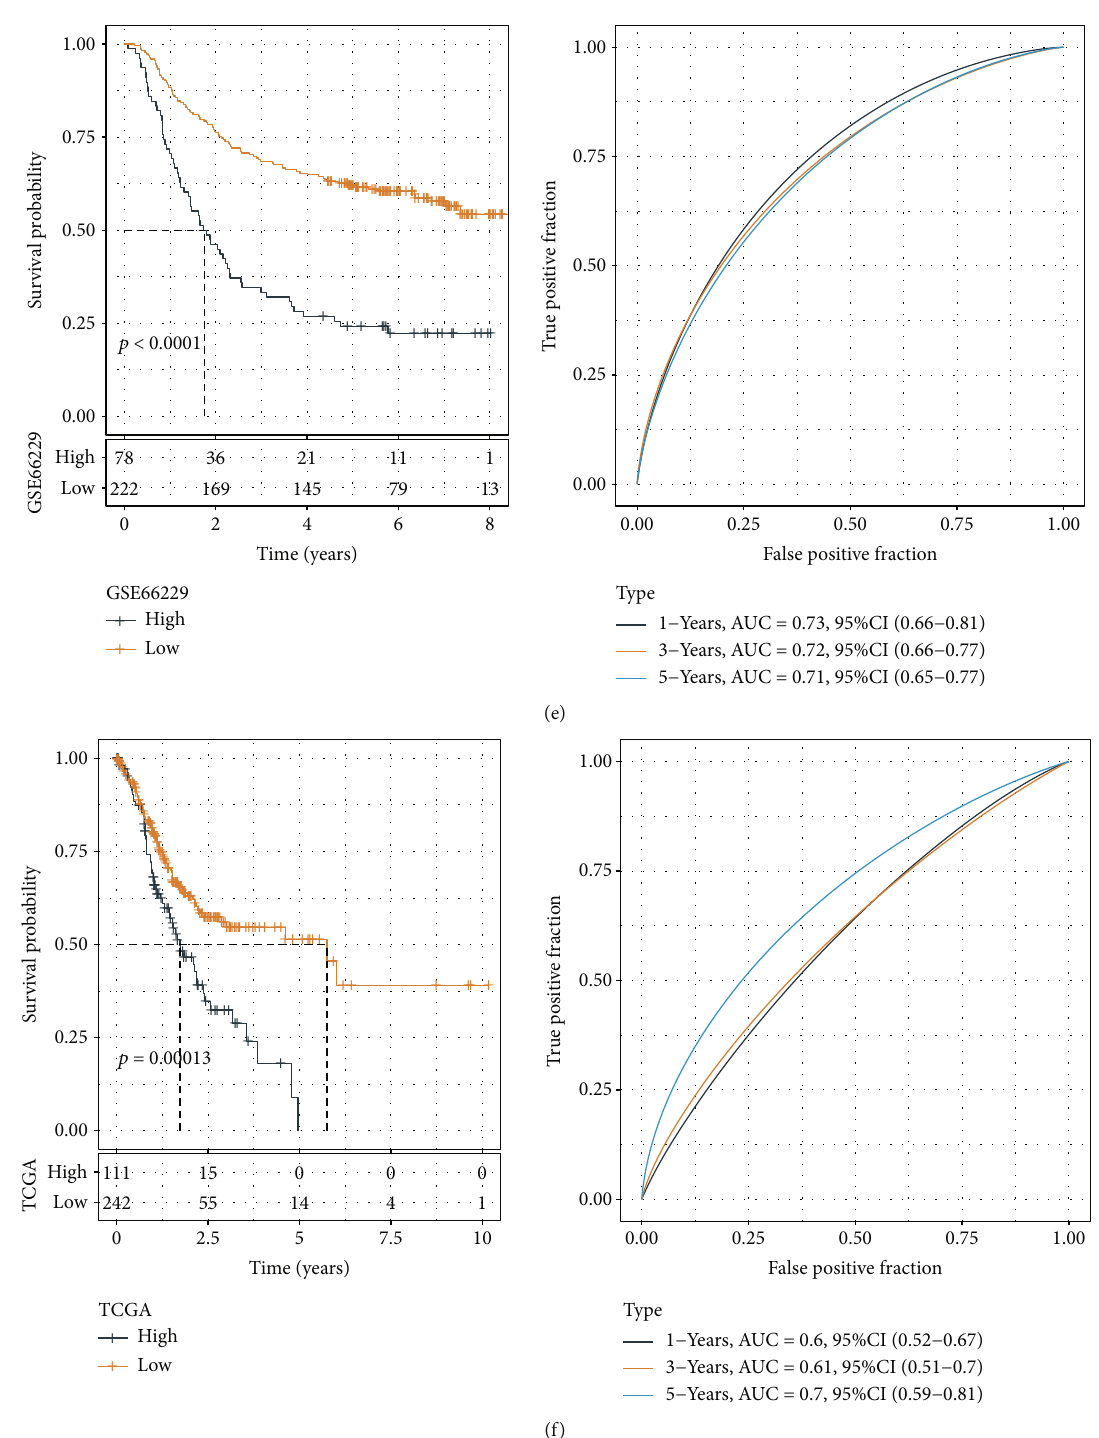
Figure 9: Construction of IRS for STAD. (a) Distribution of LASSO coe ffi cients for 40 prognostic RNAs in the GEO training cohort. Coe ffi cient pro fi les were plotted based on log ð λ Þ sequences. (b) Multifactorial results of genes for the fi nal IRS model. (c) KM and ROC analyses for the IRS model using the GEO training dataset. (d) KM and ROC analyses for the IRS model using the GEO validation dataset. (e) KM and ROC analyses for the IRS model using the entire GEO dataset. (f) KM and ROC analyses for the IRS model using the entire TCGA